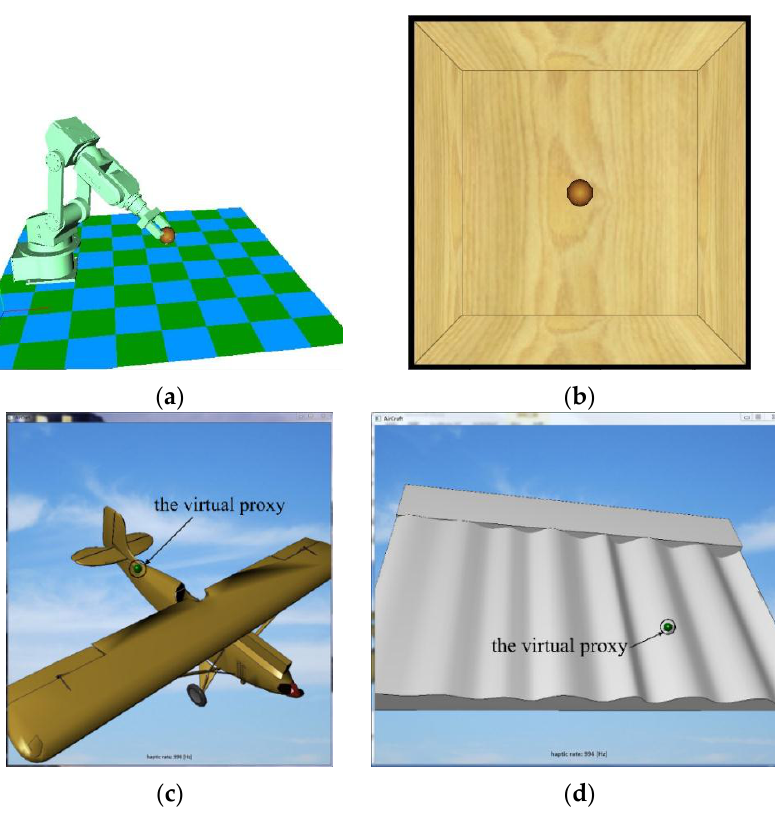
Figure 23. Four application examples: ( a ) Grasping example; ( b ) Bounding box example; ( c ) Rigid object interaction; ( d ) Position tracking example.